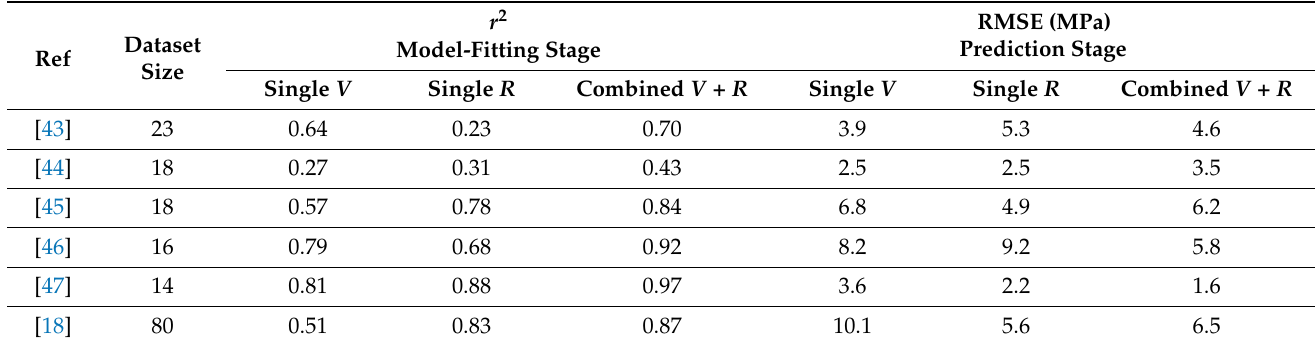
Table 2. Analyzing the efficiency of